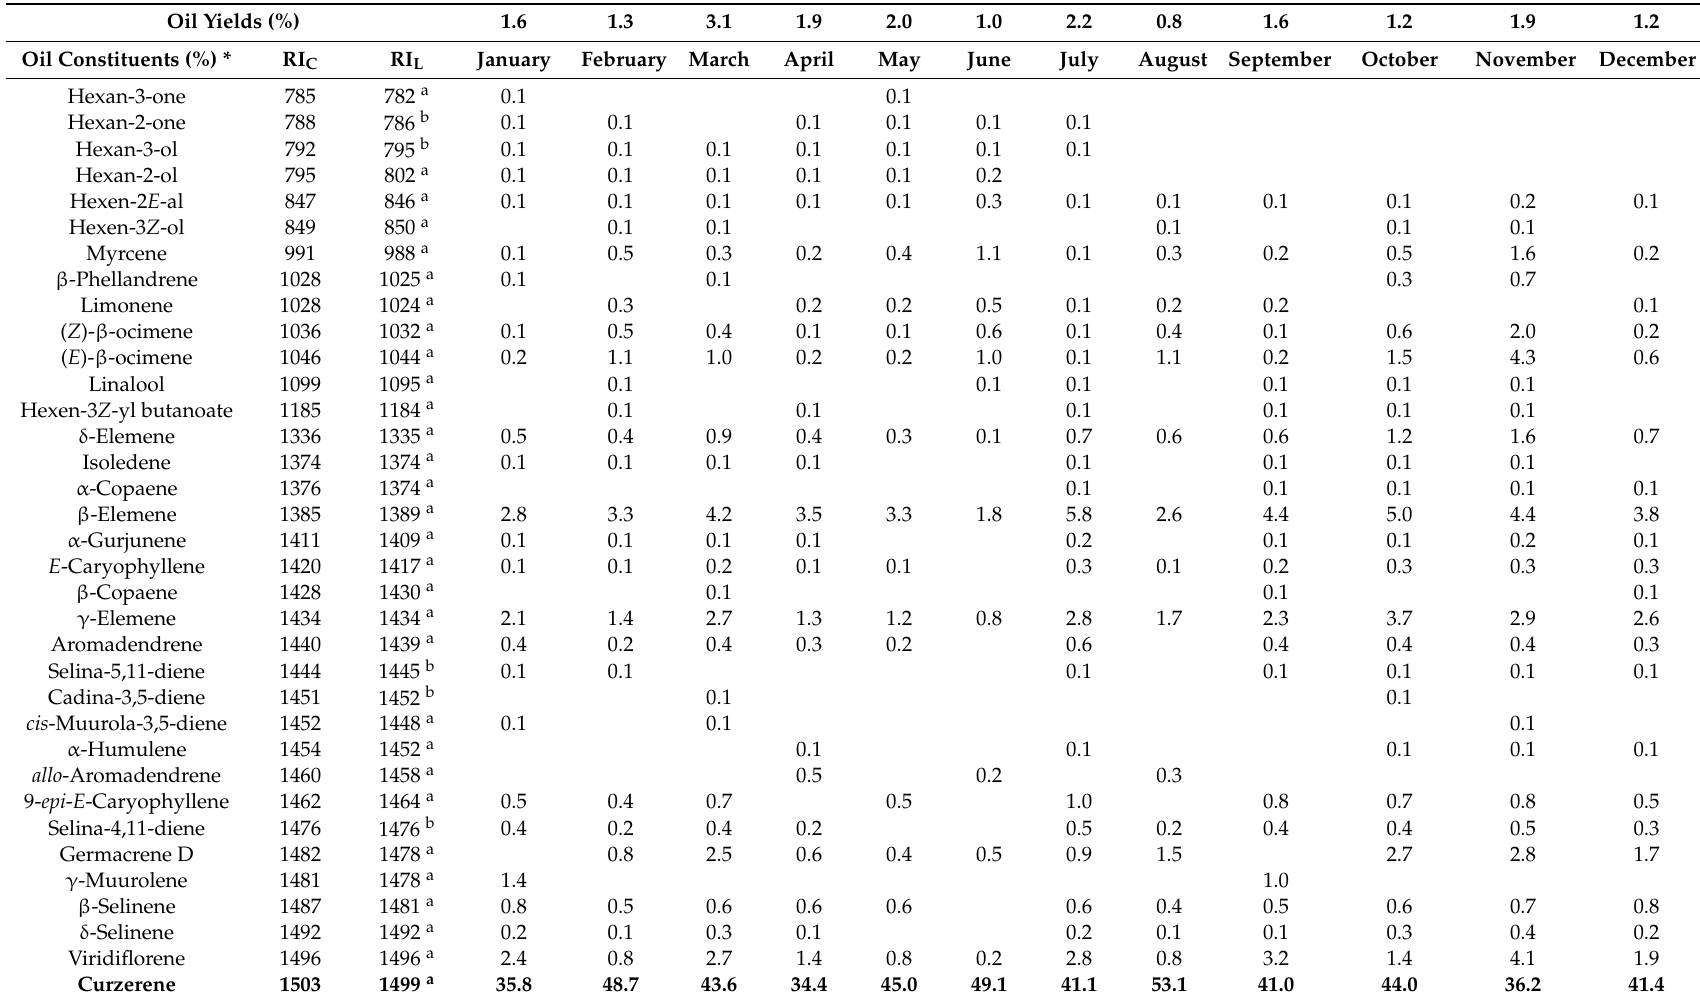
Table 1. Oil-composition of seasonal study of Eugenia uniflora